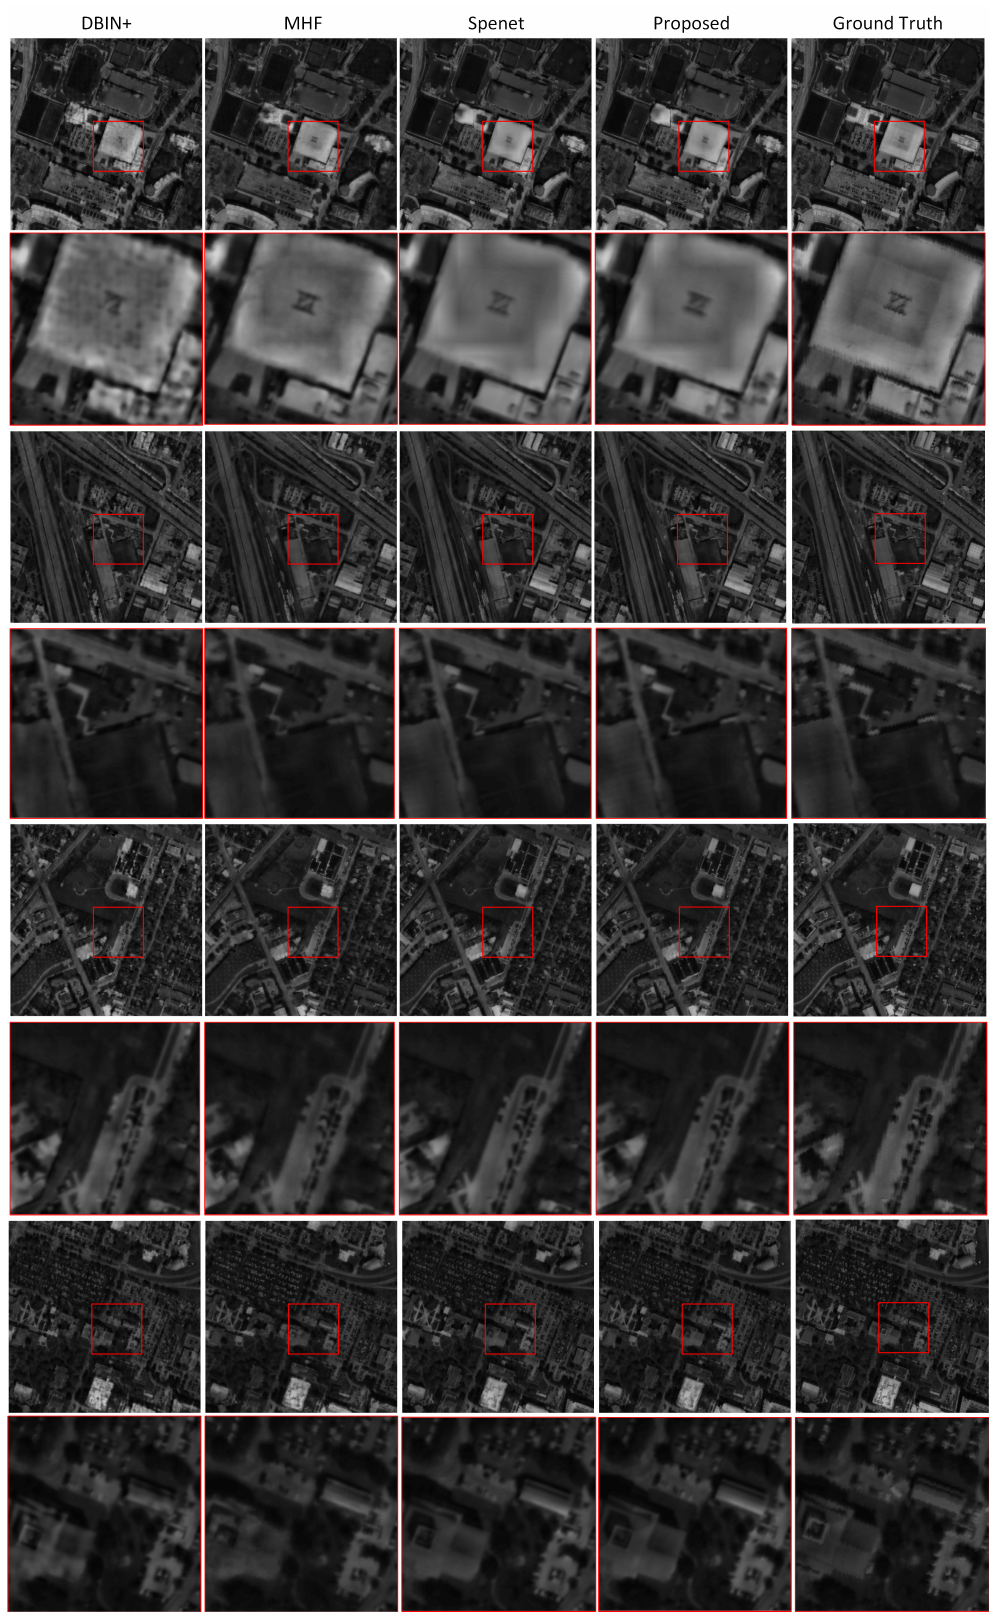
Figure 9. The visual comparisons of fusion results obtained by different methods on NCALM